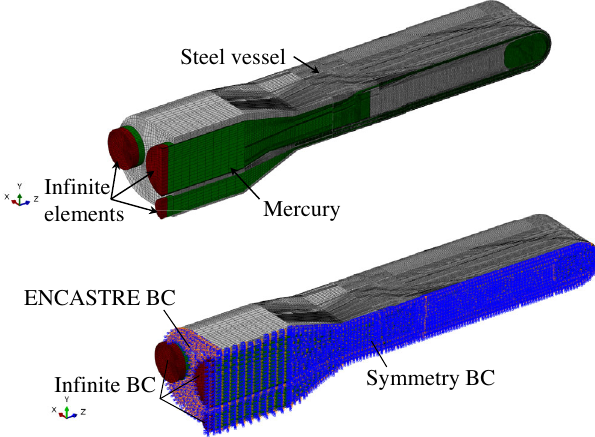
FIG. 4. Volumetric strain and pressure relationship in Riemer